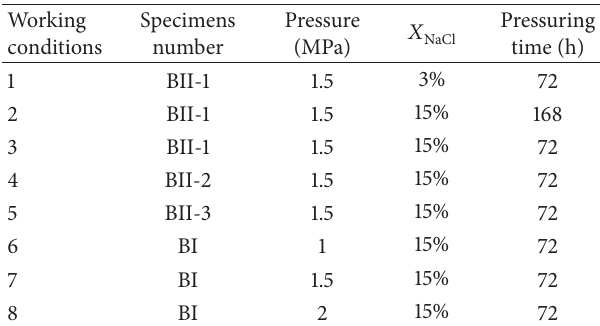
Figure 3: Chloride penetration tester. Table 6: Working conditions of chloride transport tests.